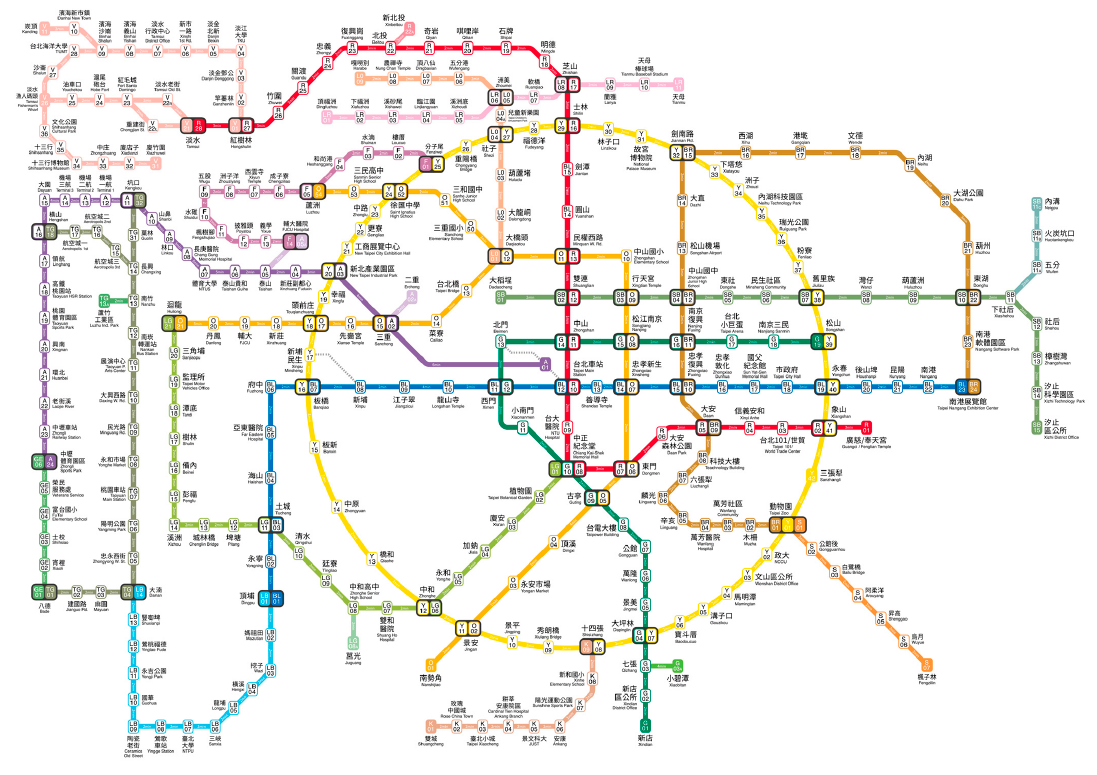
ISPRS Int. J. Geo-Inf. 2021 , 10 , x FOR PEER REVIEW